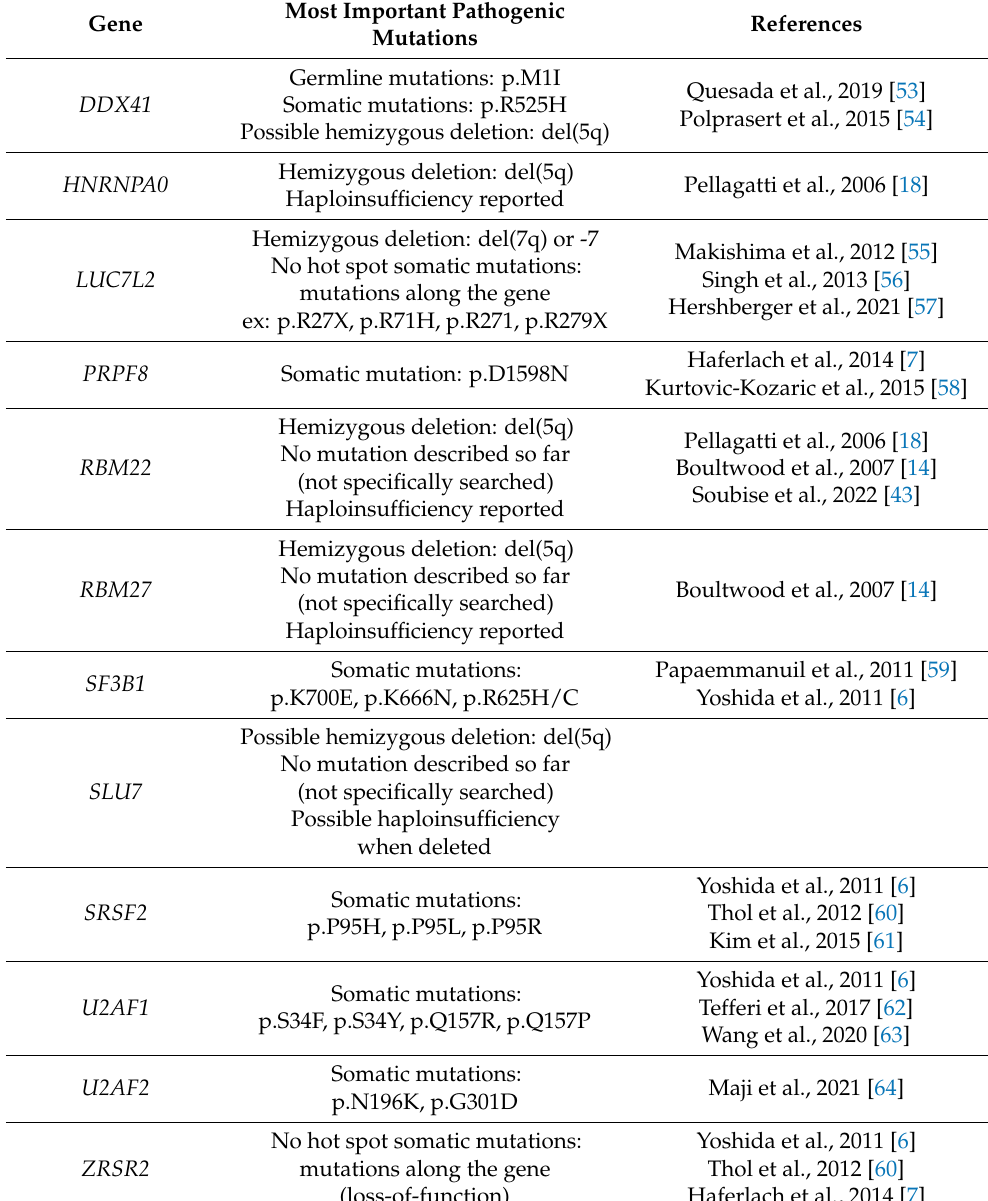
Table 1. Most important pathogenic mutations in splicing genes potentially involved in